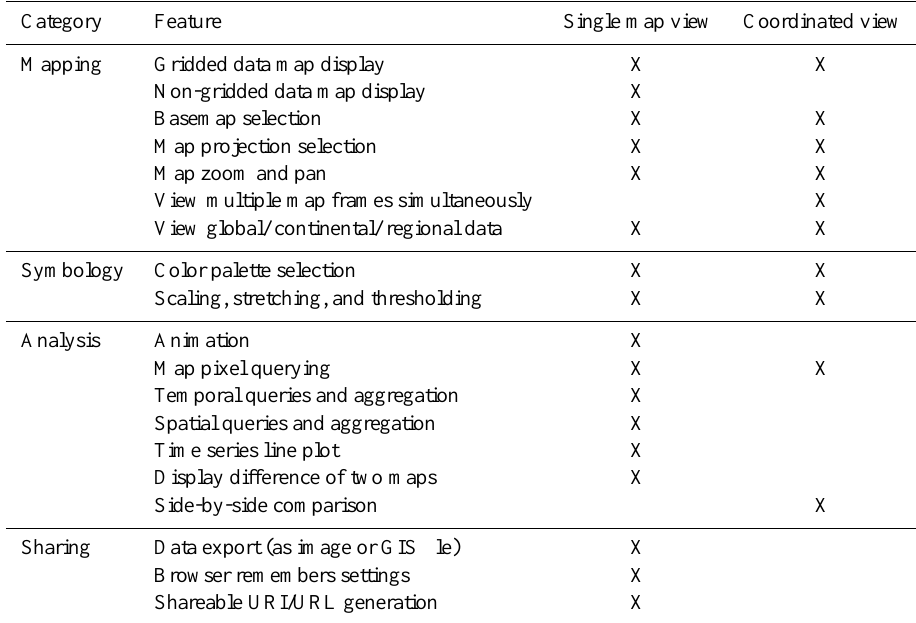
Table 3. List of features (present when marked with an X) in the two visualization modes of the Carbon Data Explorer web browser application. Category Feature Single map view Coordinated view Mapping Gridded data map display X X Non-gridded data map display X Basemap selection X X Map projection selection X X Map zoom and pan X X View multiple map frames simultaneously X View global/ continental/ regional data X X Symbology Color palette selection X X Scaling, stretching, and thresholding X X Analysis Animation X Map pixel querying Temporal queries and aggregation Spatial queries and aggregation Time series line plot Display difference of two maps Side-by-side comparison Sharing Data export (as image or GIS file) Browser remembers